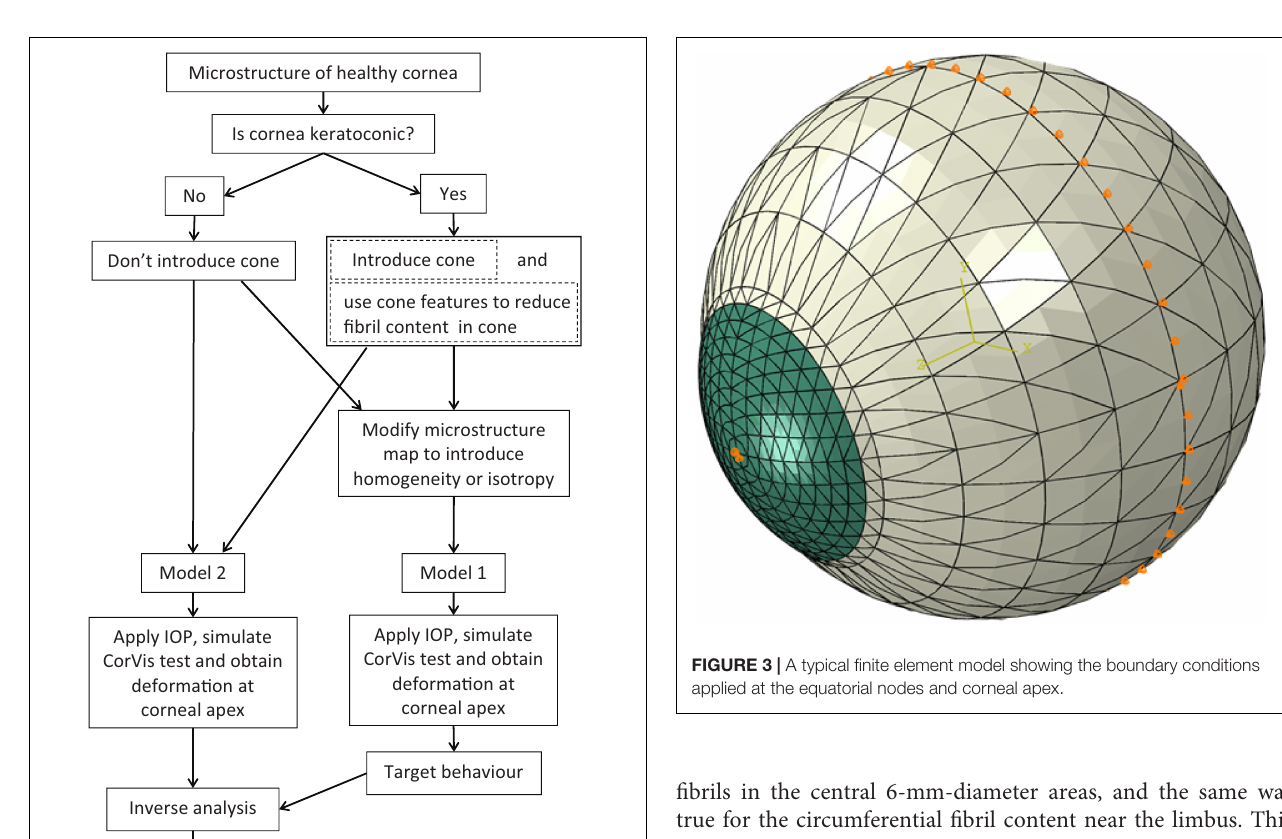
individuals. In an earlier study (Zhou et al., 2019), in which